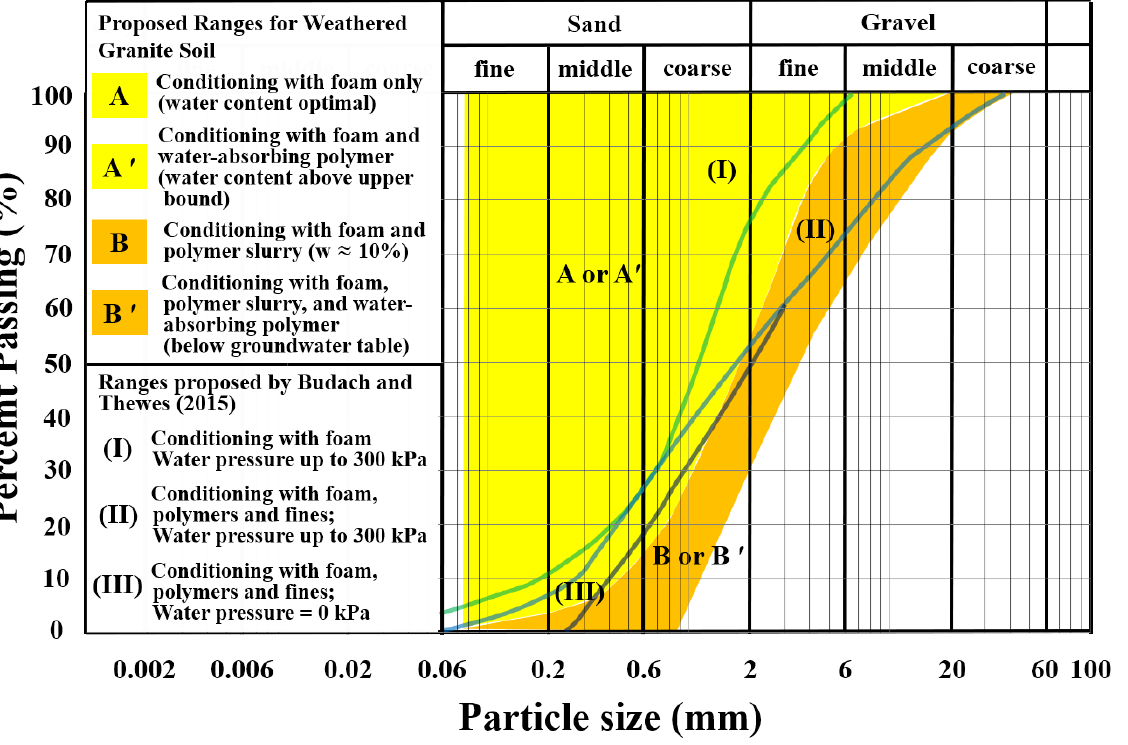
Figure 12. Application ranges of EPB shield TBM in weathered granite soil ground.